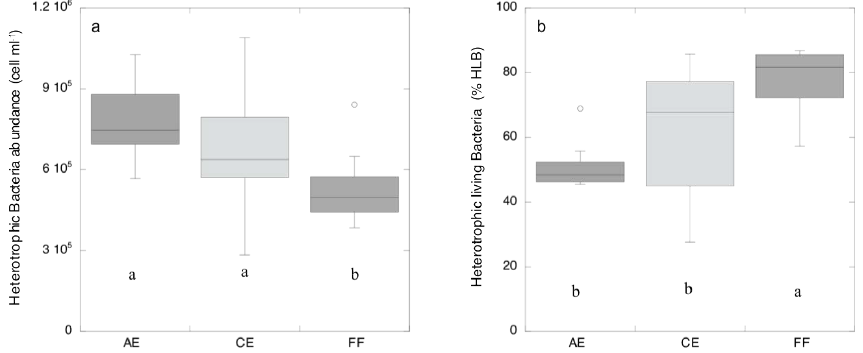
Fig. 9. Distribution of (a) the abundance and (b) viability (percentage of living cells) of the heterotrophic bacteria within AE, CE and FF stations. Boxes show the lower and upper quartiles, median, minimum and maximum values, and outliers (open circles). Boxes connected by same letter are not significantly different ( p <